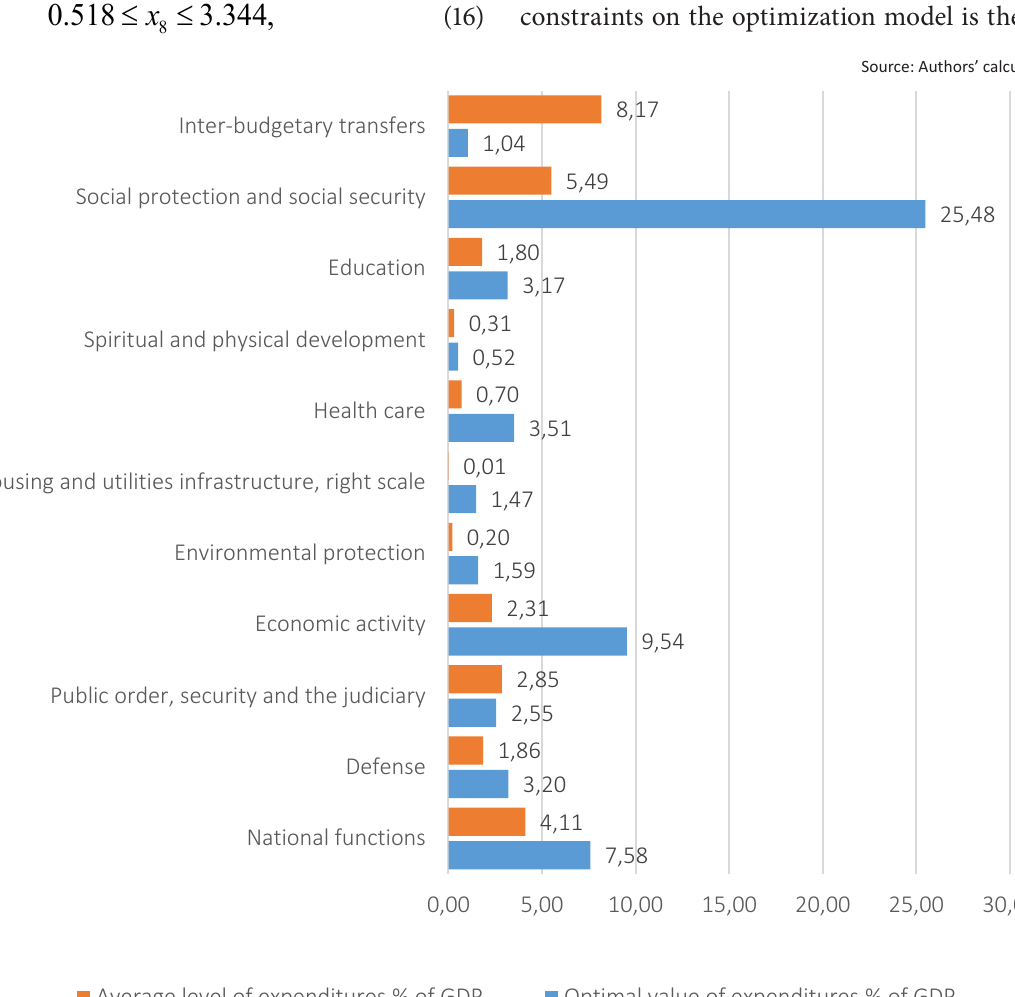
Figure 5. Comparison of the obtained optimal and available average levels of distributing state budget expenditures as a share of GDP,